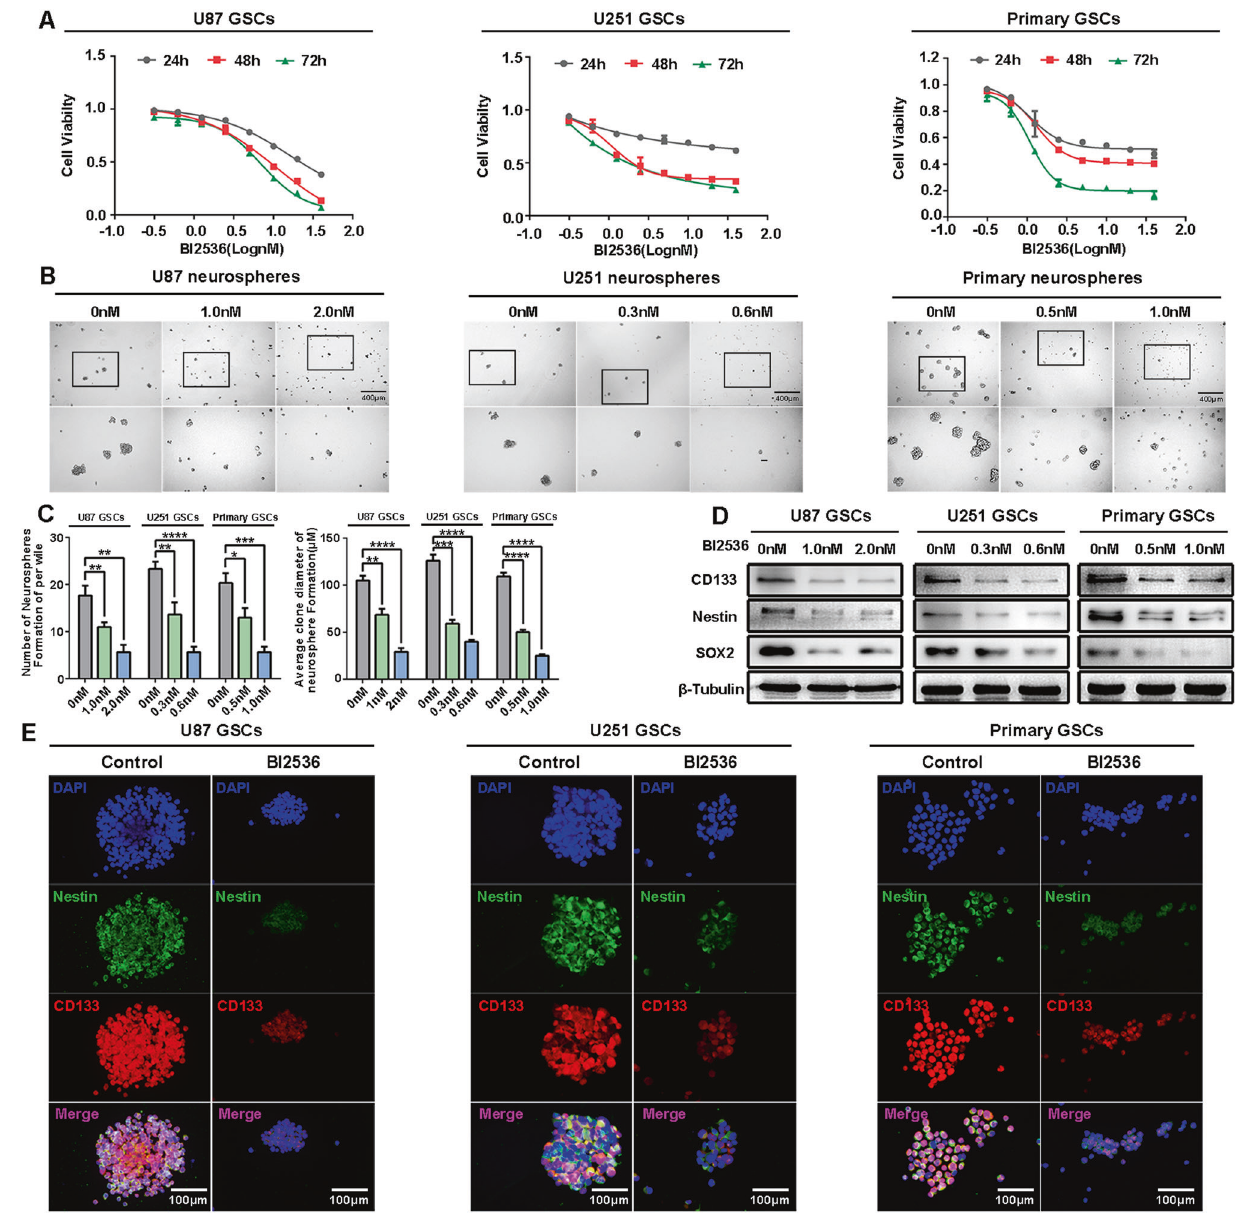
Fig. 2 PLK1 inhibition reduces the sphere formation capacity and stemness of GSCs in vitro. A U87, U251, and primary GCSs were treated with BI2536 for 24, 48, and 72 h, and cell viability was detected using the Cell Counting Kit-8(CCK-8) assay. B The representative images of GSCs neurospheres showed that the neurosphere formation ability of GSCs was signi fi cantly inhibited by BI2536 treatment. The outlined sections of top images were de fi ned as higher magni fi cation sections below. n = 3, scale bar = 400 μ m. C The quanti fi cation of numbers and diameter of the GSCs neurospheres shows that the neurosphere formation ability of GSCs was inhibited after BI2536 treatment. Data are shown as means ± SD, n = 3, # P = NS, * P < 0.5,** P < 0.1, *** P < 0.001, **** P < 0.0001, Student ’ s t test. D U87, U251, and primary GSCs were treated with BI2536 for 24 h; protein expression of CD133, Nestin, and SOX2 was detected by Western blot. E Cells were immunostained for Nestin (green) and CD133 (red) and stained with DAPI (blue). Scale bar = 100 μ